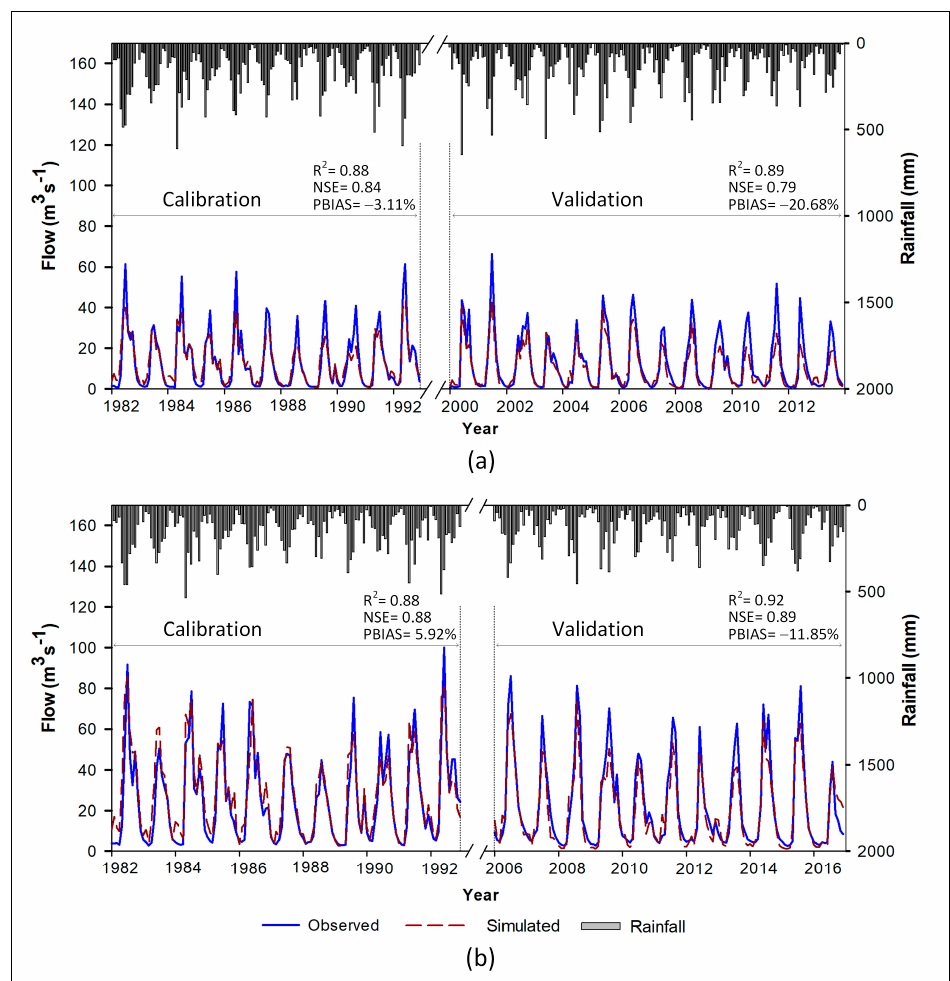
323 324 Figure 3. Calibration and validation of the total monthly flow for ( a ) Quino basin and ( b ) Muco